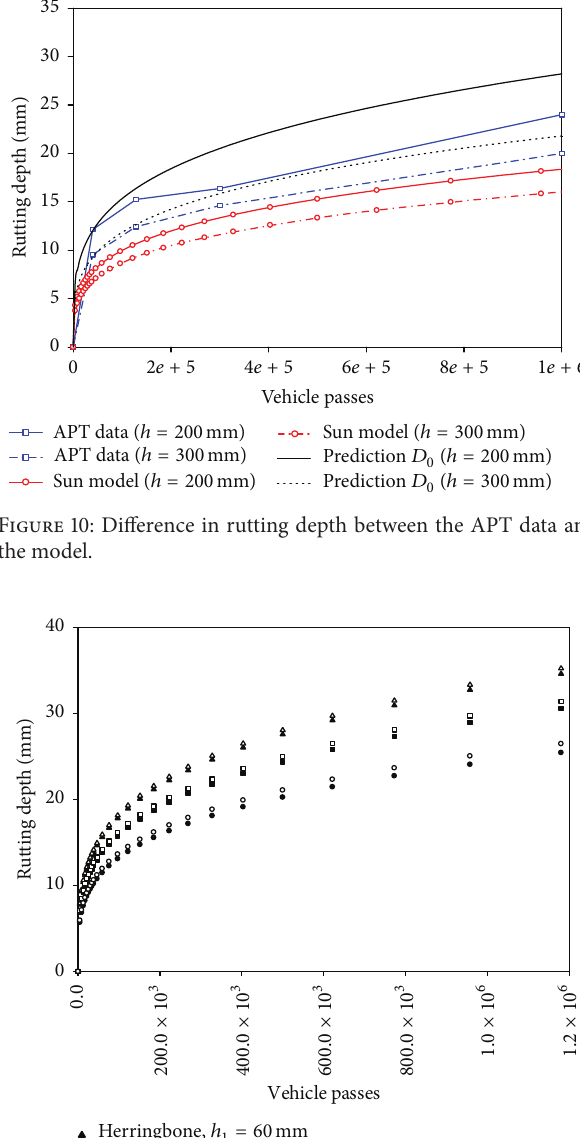
Figure 9: Rutting depth by traffic load (300 mm thick base).